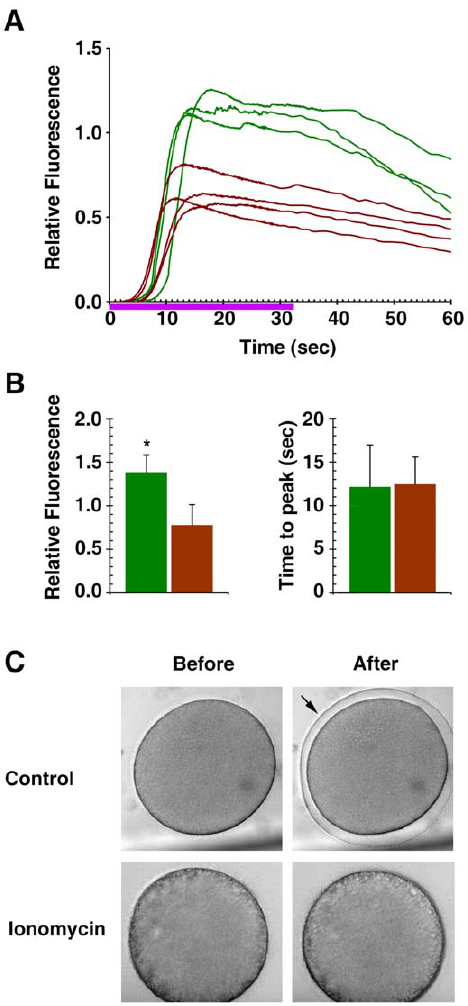
Figure 6. Ionomycin-exposed eggs with cortical granule disruption still respond to InsP 3 with an intracellular Ca 2 + release, but to a reduced extent. A. aranciacus oocytes were exposed to 5 m M ionomycin for 5 min at the GV stage and microinjected with caged InsP 3 and Calcium Green. The oocytes were matured in the fresh seawater containing 10 m M 1-MA and then irradiated with UV to photoactivate the Ca 2 + -mobilizing second messenger. ( A ) Results of one of the three independent experiments showing the trajectories of the quantified Ca 2 + responses at the entire cytoplasmic field. Ca 2 + responses in the control eggs and the eggs briefly exposed to 5 m M ionomycin at the GV stage were shown in green and brown curves, respectively. Violet line indicates the duration of UV irradiation. ( B ) Summary of the data pooled from three independent batches of experiments comprising 3 or 4 microinjected eggs with (brown bars, n=10) or without (control, green bars; n=9) ionomycin pretreatment at the GV stage. The average amplitude (mean 6 standard deviation, left histogram) and the time interval between the onset and the peak of the Ca 2 + signals (right histogram) were depicted separately. Asterisk indicates a significant difference between the control and the ionomycin-pretreated eggs ( p , 0.0001). ( C ) Despite the substantial amount of Ca 2 + released, the ionomycin-pretreated eggs did not undergo elevation of the vitelline layer in all